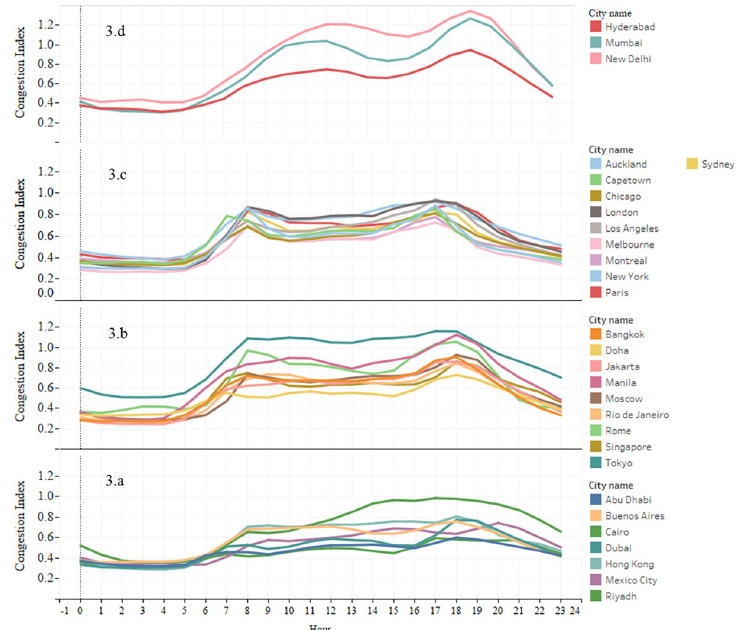
Fig 3. Temporal distribution of congestion index. a. cities with a low congestion index, b. and c. cities with moderate to high congestion index, d. an exception where the rate of dissipation is found to increase as the congestion increases.